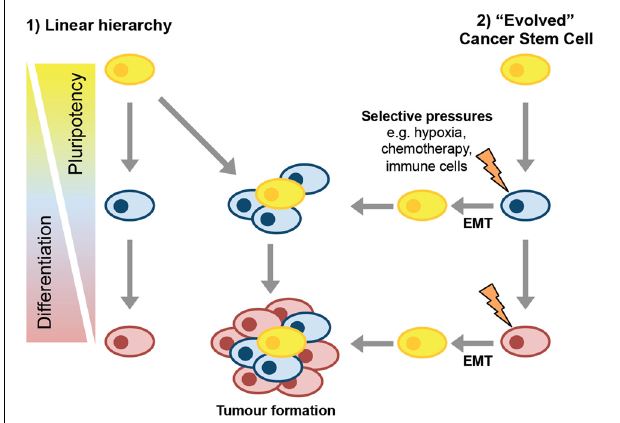
FIGURE 1 | Models of CSC formation. In the linear hierarchy model of CSC formation, the transformation events that drive tumorigenesis occur in a stem or progenitor cell that then gives rise to more differentiated progeny as the tumor develops. These differentiated progeny have reduced tumor-forming potential. In the second model, cancer stem cells evolve, perhaps via induction of EMT, either as part of disease progression or in response to selective pressures in the tumor